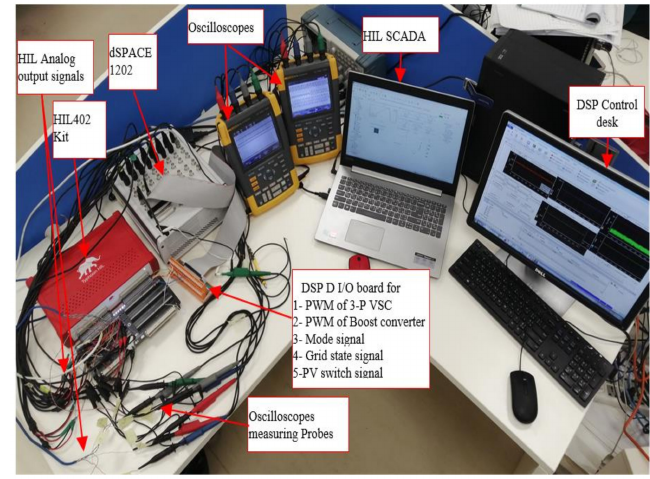
Figure 23. Experimental setup of the system.